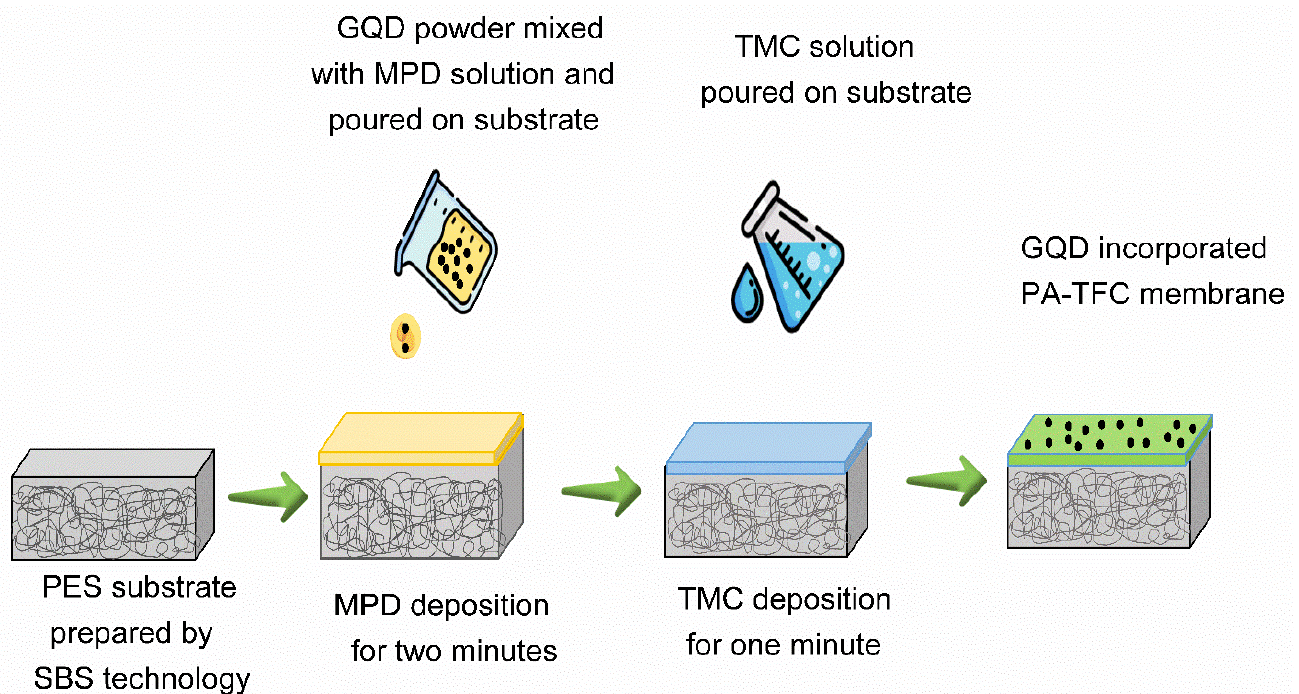
Figure 3. Diagrammatic representation of TFNC membrane preparation. To prepare the TFNC membranes, three different loadings of B-GQDs, i.e., 0.025, 0.050, and 0.075 wt.%, were first added to the MPD solution. The procedure for the fabri- cation of TFNC membranes was the same as that of the TFC membrane. The TFNC mem- branes were named 0.025-B-GQD/PA TFNC, 0.050-B-GQD/PA TFNC, and 0.075-B- GQD/PA TFNC for B-GQD loadings of 0.025, 0.050, and 0.075 wt.%, respectively.